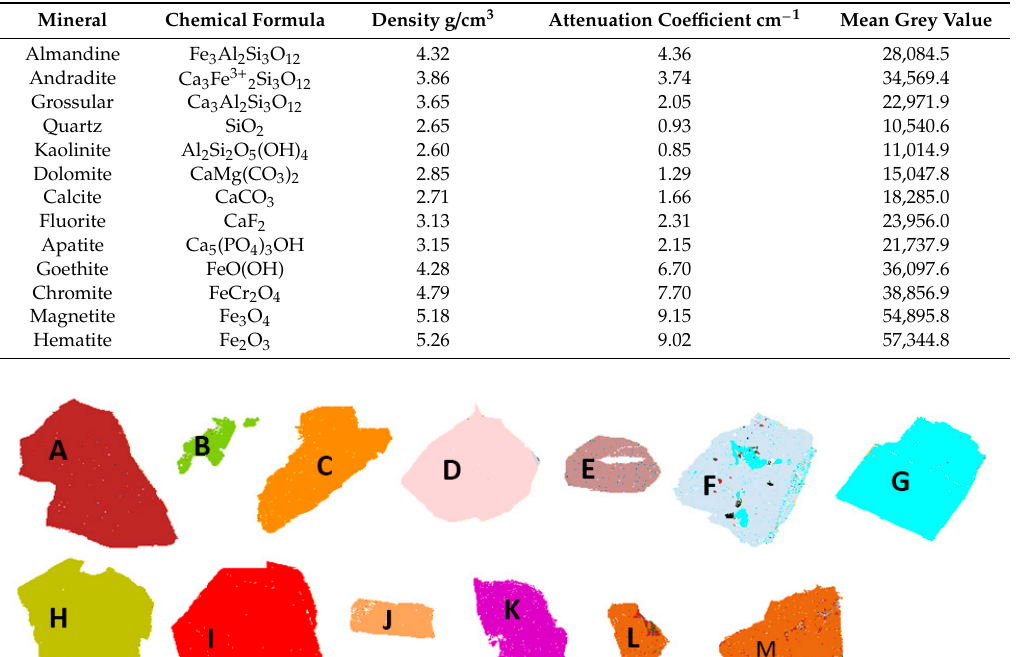
same. This means that the X-ray voltage for each target material would be different in order to achieve the same minimum required attenuation coefficient difference to differentiate minerals. Table 3. Grey value variation of different minerals with their corresponding density Table 3. Grey value variation of di ff erent minerals with their corresponding density (https: // www. (https://www.mindat.org/) and linear attenuation coefficients at 45.5 keV effective energy. mindat.org / ) and linear attenuation coe ffi cients at 45.5 keV e ff ective energy. Mineral